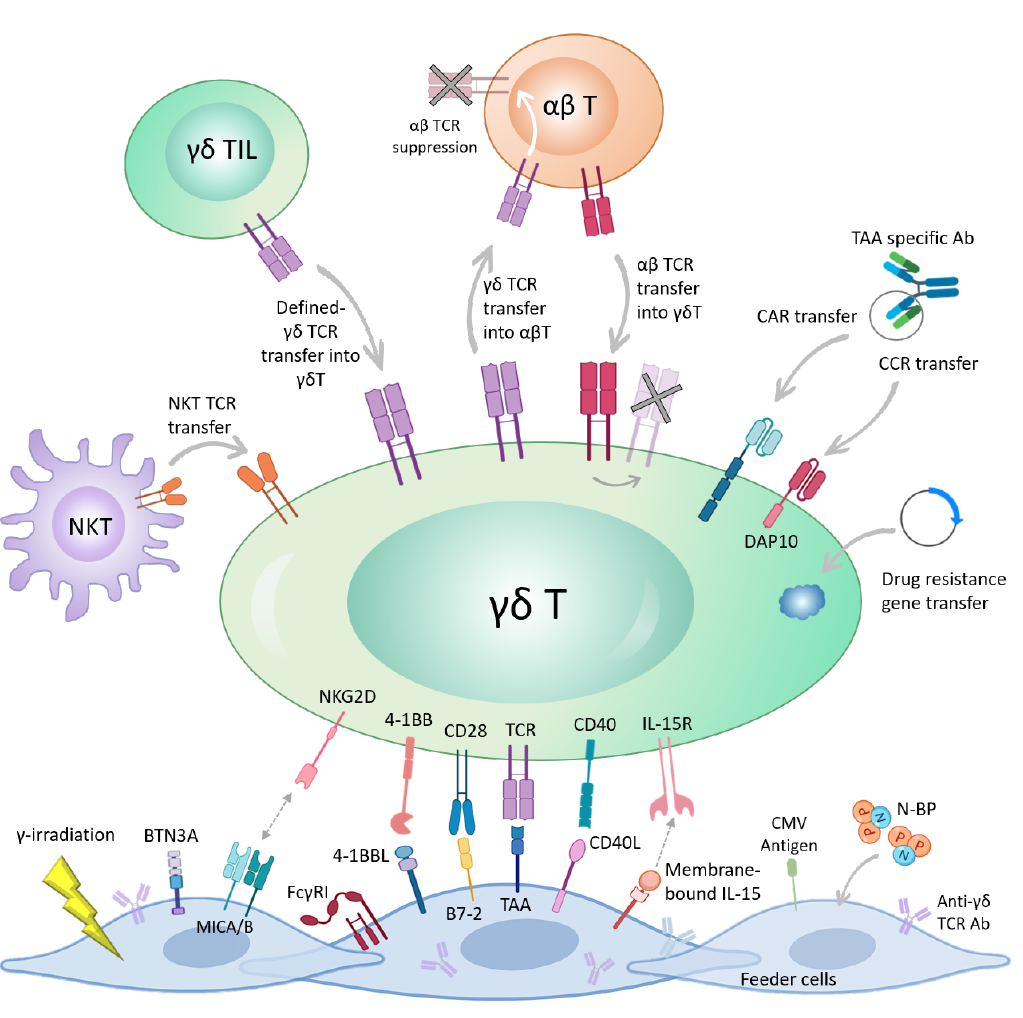
Figure 1. Di ff erent genetic engineering strategies for harnessing the anti-tumor activity of γδ T cells. TCR-based engineering methods include TCR gene transfer from αβ to γδ T cells and vice